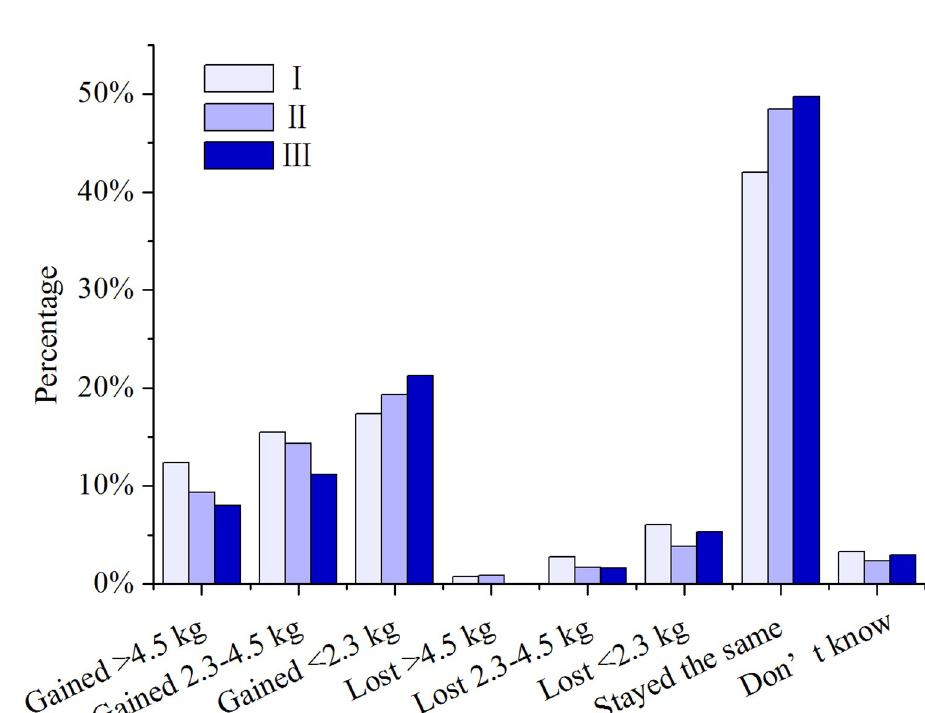
Fig 5. Body weight change during the COVID-19 pandemic in different age groups (p = 0.018).